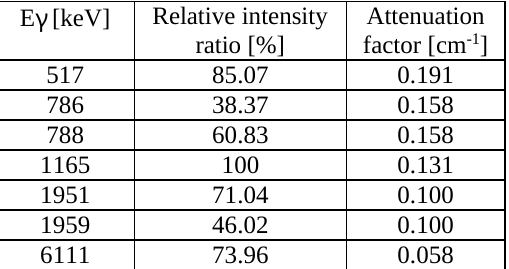
Table 1 : Major γ -energies, relative intensity ratios, and attenuation factors in capture reaction 35 Cl(n, γ ) 36 Cl